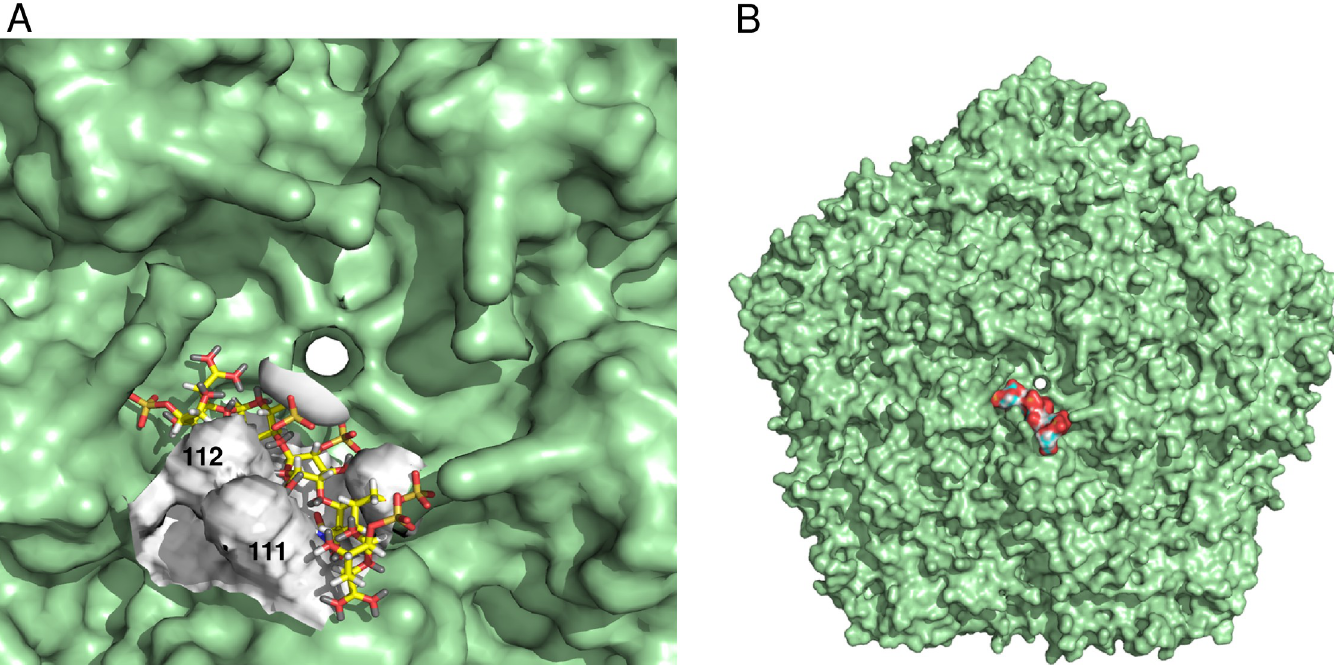
Fig 2. GRID [41] was used to find the energetically favorable binding site for HSPG on the SAT1 modelled mutant capsid. ( A ) The GRID calculation was performed for a 20 Å radius around the 5-fold axis using pyramidal sulfur as a probe. VP1 residue 112 is the most likely site of interaction with molecular interaction energy of -8.2 kcal/mole. The interaction energy increased to -10 kcal/mole when the grid was centered at VP1 residue 112. ( B ) Five linked heparin disaccharide molecules were docked using the default parameters of GOLD onto the SAT1 modeled mutant pentamer structures. A 30 Å 3 region from VP1 residue 112 was defined for docking and the GOLD fitness score function was used to rank the docking poses. The best docking pose is shown (GOLD score = 127). The equivalent process for the wild-type virus produced a less satisfactory docking (GOLD score = 102, docking not shown).